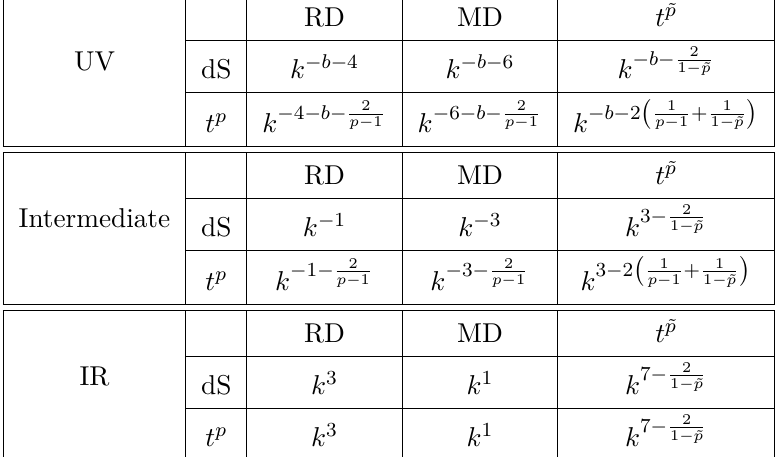
Table 2 . The slope of the GW spectrum in different frequency regimes. In the UV regime, the h i 2 ˜ E i GW scales as ( k ) ˜ G f ( k ) k − b . We use b = 1 for the numerical results presented here. The factor 0 0 h i 2 ˜ E i ( k ) ˜ G f ( k ) encodes the effect from the propagation of the GW, k − b is contributed by the 0 0